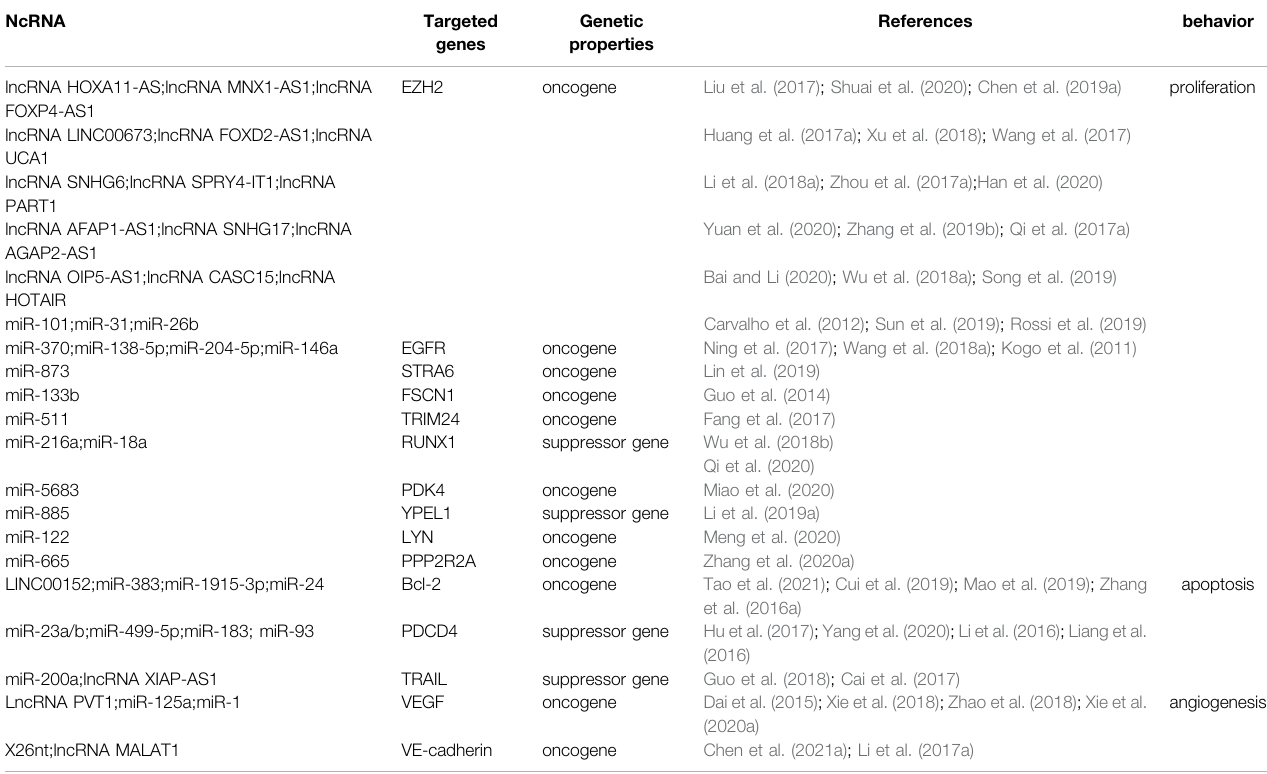
TABLE 1 | NcRNAs and oncogenes and suppressor genes in gastric cancer